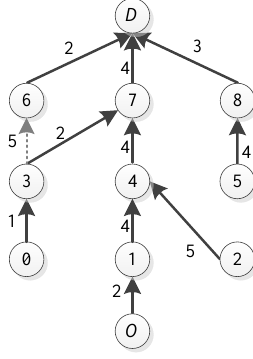
Figure 2. The update method of the shortest path